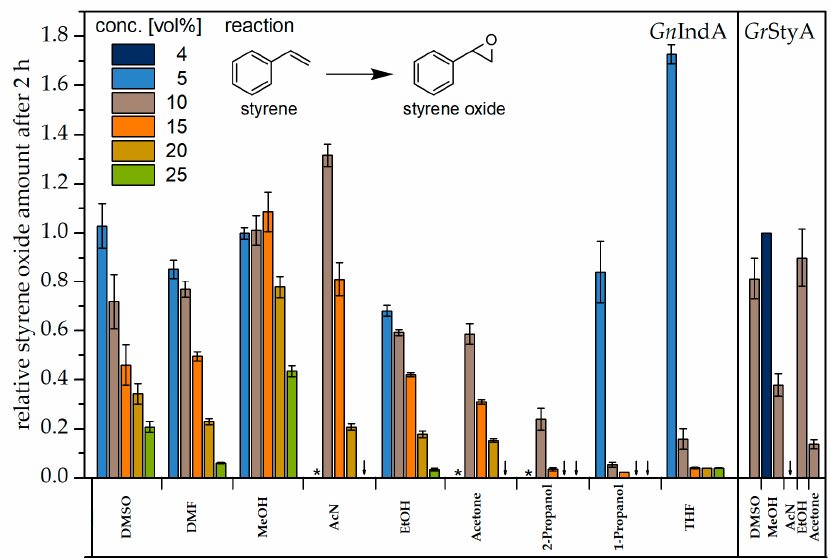
Figure 3. Relative styrene oxide amount formed by Gn IndA (left) and Gr StyA (right) in presence of nine organic solvents: In general, for Gn IndA a remarkably high product formation up to 15 vol.% cosolvent was observed while MeOH and THF were outstanding due to the stable product formation at higher concentrations and the increased product formation in lower concentration ranges, respectively. Except for DMSO and EtOH, a significantly reduced product amount was detected for Gr StyA already at 10 vol.% cosolvent. The relative styrene oxide amount is normalized to 5 vol.% MeOH ( Gn IndA, 0.70 mM styrene oxide) resp. 4 vol.% MeOH ( Gr StyA, 0.47 mM styrene oxide). * not